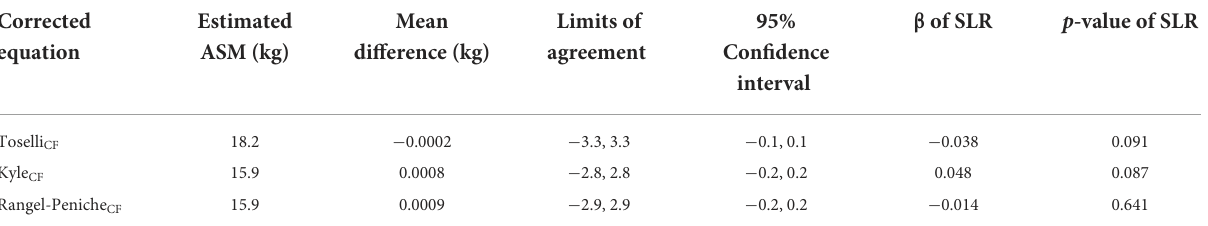
TABLE 6 Validation data of the three corrected BIA equations. β of SLR p -value of SLR Corrected Estimated Mean Limits of 95% equation ASM (kg) difference (kg) agreement Confidence interval Toselli CF 18.2 − 0.0002 − 3.3, 3.3 − 0.1, 0.1 − 0.038 0.091 Kyle CF 15.9 0.0008 − 2.8, 2.8 − 0.2, 0.2 Rangel-Peniche CF 15.9 0.0009 − 2.9,